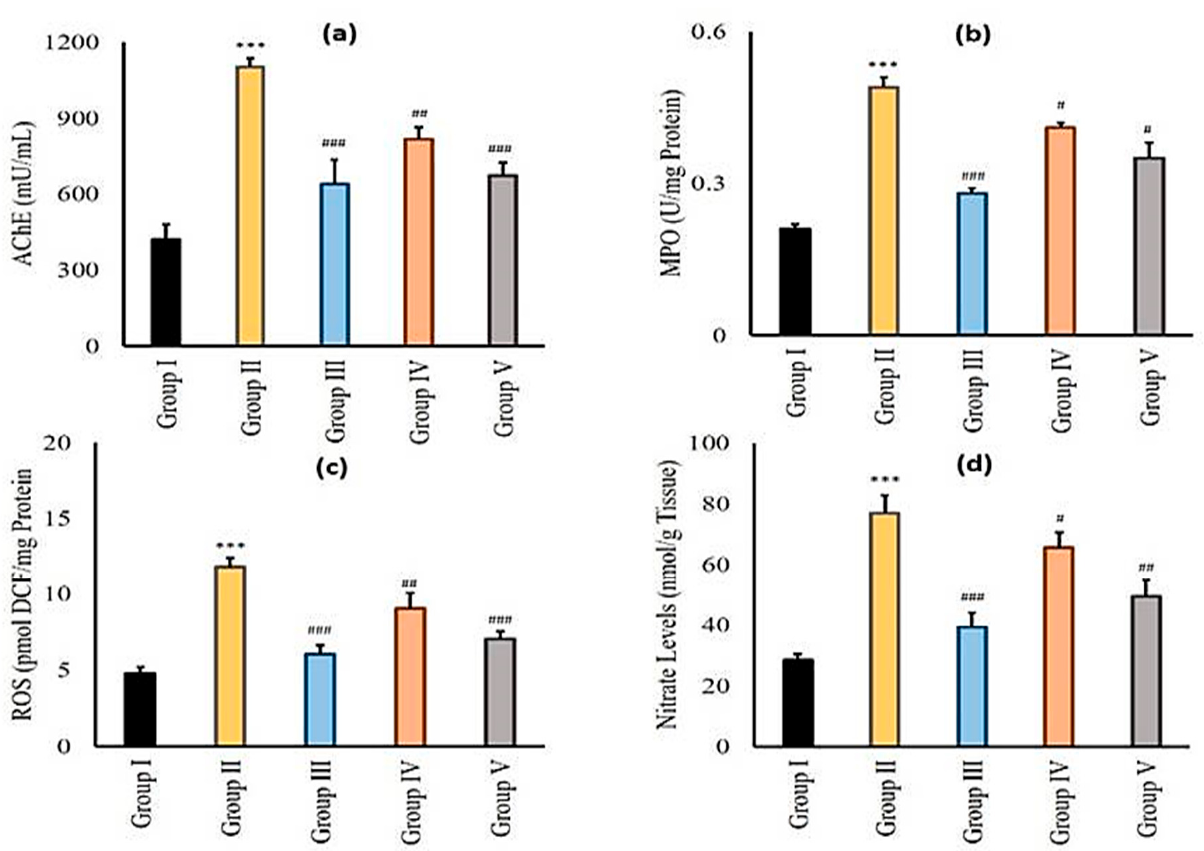
Figure 2. Panel of graphs represents effects of zingerone on AChE ( a ), MPO ( b ), ROS ( c ), and NO ( d ) levels on LiCl-and- pilocarpine-induced SE. Values are significantly different in LiCl and pilocarpine group (*** p < 0.001) as compared to control group. Results that we got are significantly different from LiCl and pilocarpine group as the main comparison is with LiCl and pilocarpine group only ( # p < 0.05, ## p < 0.01 and ### p < 0.001). Group I: Normal saline (10 mL/kg b.w.), Group II: LiCl (3 mEq/kg b.w.) + pilocarpine (30 mg/kg b.w.), Group III: Sodium Valproate (300 mg/kg b.w.) + LiCl (3 mEq/kg b.w.) + pilocarpine (30 mg/kg b.w.), Group IV: zingerone (25 mg/kg b.w.) + LiCl (3 mEq/kg b.w.) + pilocarpine (30 mg/kg b.w.), Group V: zingerone (50 mg/kg b.w.) + LiCl (3 mEq/kg b.w.) + pilocarpine (30 mg/kg